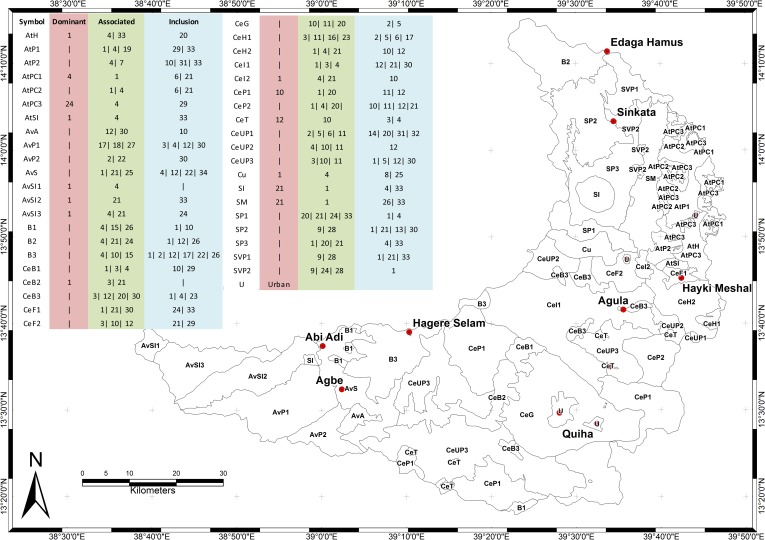
Land systems of Giba catchment with dominant and associated soil types and inclusions.Multiple soil units within a subdivision are separated by |. Soil units are named and characterised in Table 5, and their suitability for agricultural field crops in Table 6. A typical catena for each soil unit has been prepared by Tielens [50]. See the .KMZ file in S2 File, for visualizing the map in Google Earth.